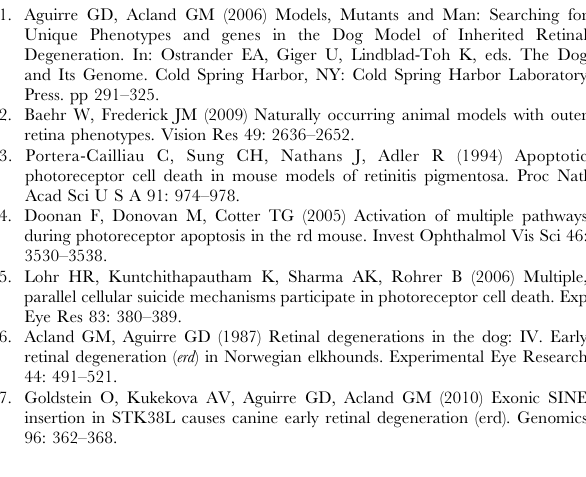
(TIF) Figure S2 Nestin, cd18 and PAX6 labeling. Representative single (A1,2-Nestin, B1,2-CD18; green) or double (C1,2-PAX6- red, rod opsin-green) labeling, with DAPI (blue) nuclear staining of normal or erd retinas of different ages. (A1, A2) Nestin labels cells only in the retinal periphery (arrowhead) near the ora serrata (ora). (B1, B2) CD18 labeling of microglia is limited to the outer and inner plexiform layers (*). (C1, C2) A population of cells in inner border of the INL, presumably Mu¨ller cells, labels intensely with PAX6 (arrowheads); labeling is also present in the ganglion cell layer (arrows). Note rod opsin delocalization into the mutant ONL (C2). Scale bar= 20 m m. (TIF) Table S1 Antibodies and reagents used for immunohistochem- istry and